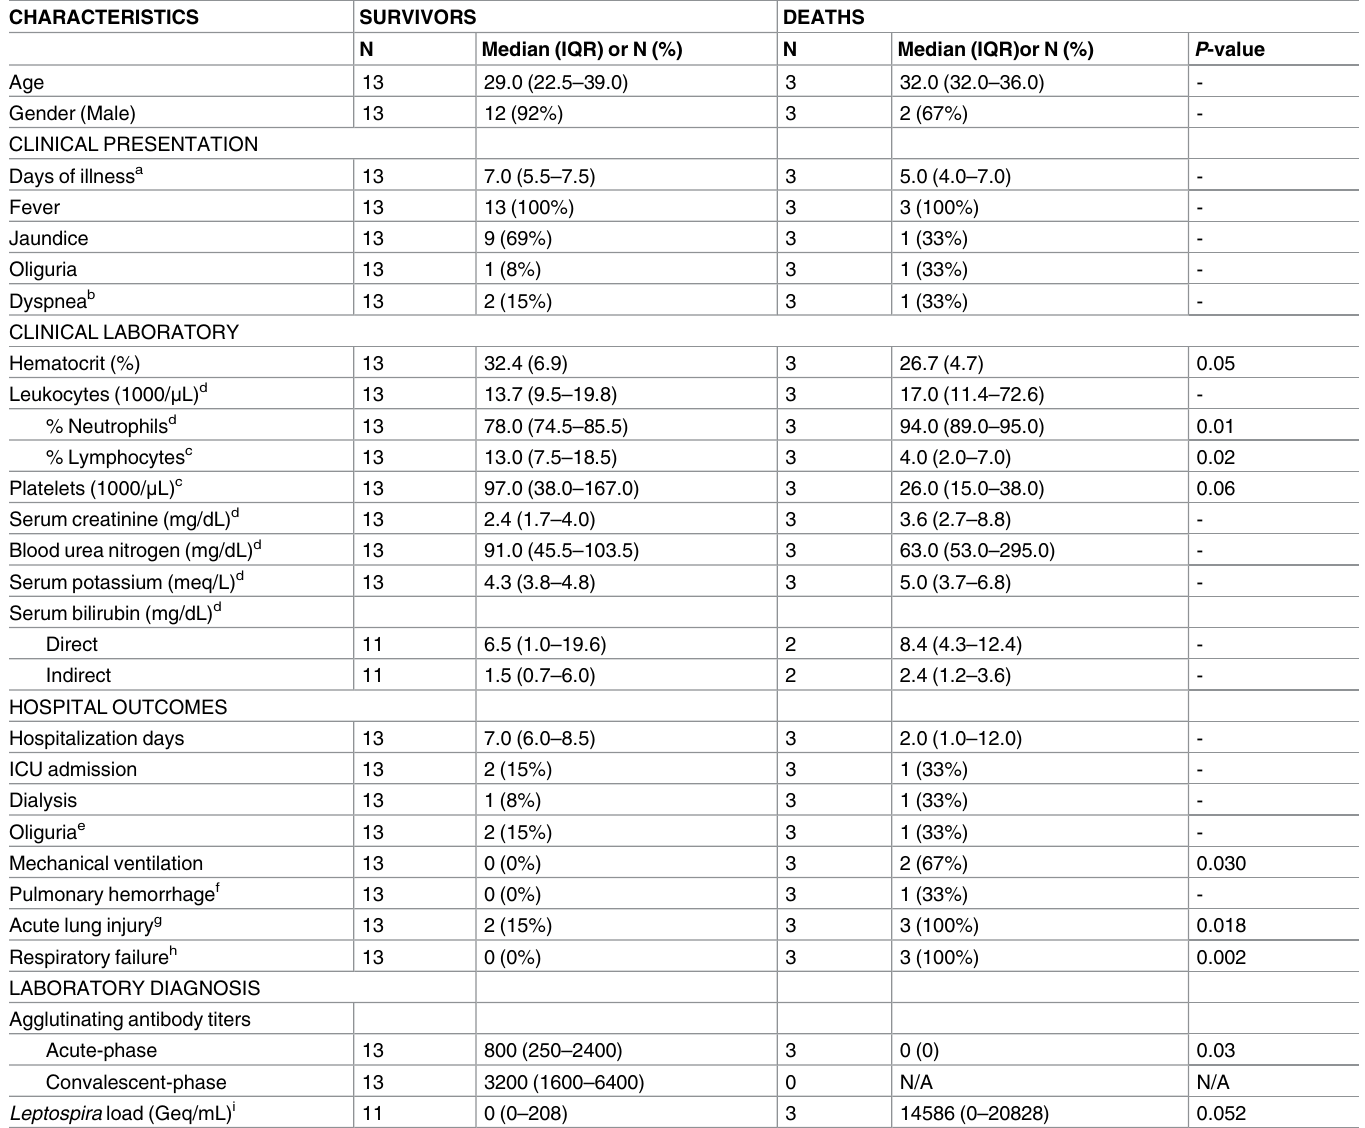
Table 1. Characteristics of leptospirosis patients during hospitalization.